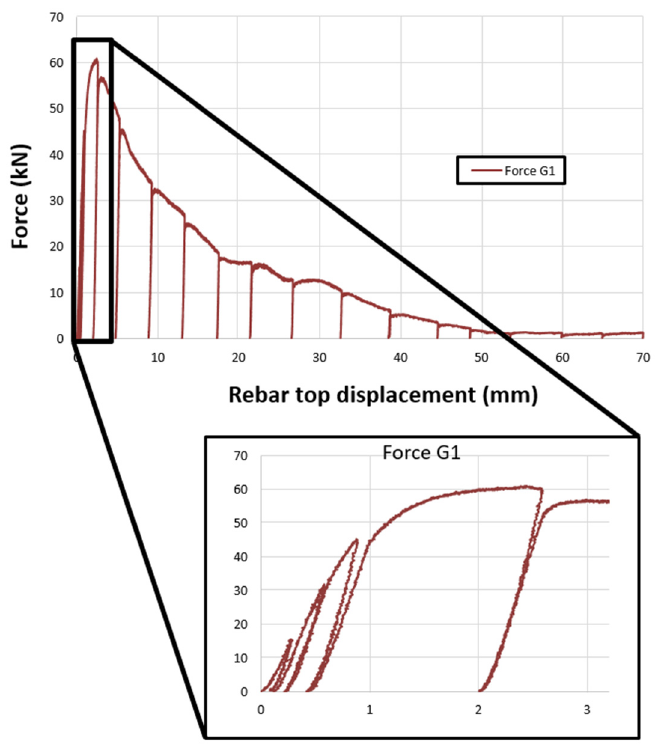
Figure 14. The SCI mechanical behavior under push-in testing (Adapted with permission from reference [57].